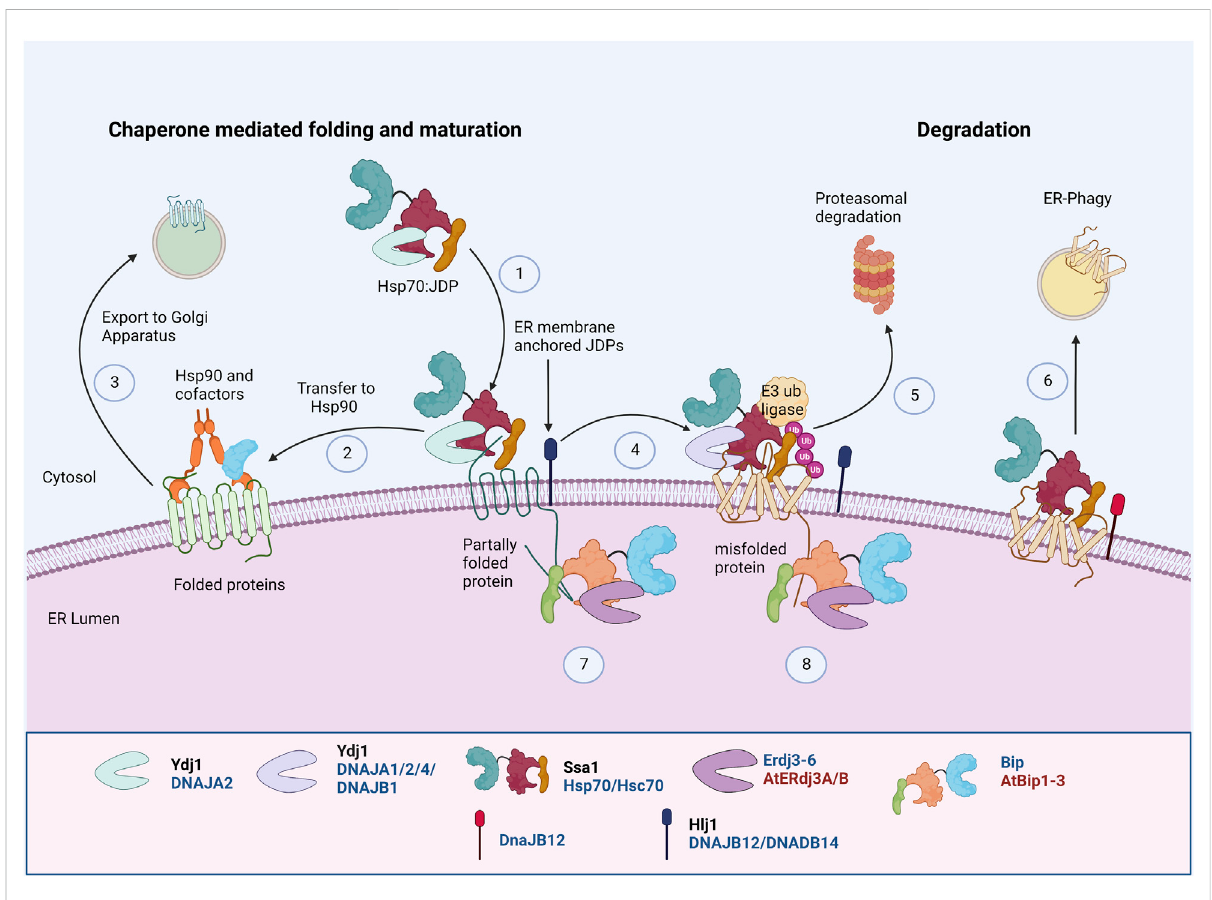
FIGURE 3 Protein Quality Control of PM proteins in ER membrane. PM proteins ’ folding and maturation at ER involves both cytosolic and ER luminal Hsp70:JDP machineries. The cytosolic Hsp70:JDPs regulatethePQC byinteractingwith unfolded/partially foldedproteins atthecytosolicdomain Y, H (1),mediatingtheinteractionwithHsp90forfolding Y,H (2)andfurthertraf fi ckingtoGolgi(3)(Youkeretal.,2004;Donnellyetal.,2013;Lietal.,2017). Defect in proper folding and maturation, can re-direct them for ubiquitination Y,H (4) and further proteasomal Y,H (5) or lysosomal degradation H (6) (Nakatsukasa et al., 2008; Kim and Skach, 2012; He et al., 2021). Similarly, the luminal Hsp70:JDPs regulate the folding, maturation A, H (7) and degradation A,H (8)ofPMproteinsbyinteractingattheluminaldomains (ParkandSeo,2015;Jietal.,2016). Y Literature availableinYeast; H Humans; A Arabidopsis. Names of Hsp70 and JDPs are denoted in different colors; Black for Yeast; Blue for